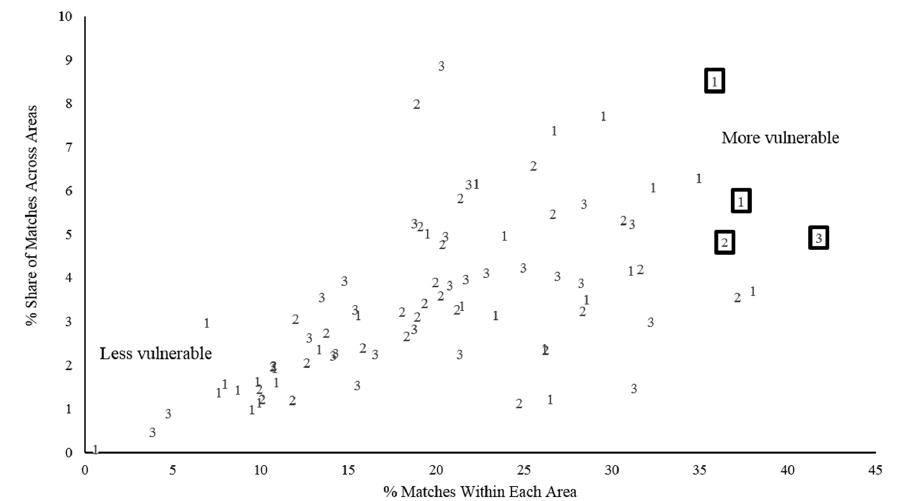
Figure 3. Areas by percentage match to the three cluster profiles (population weighted data).